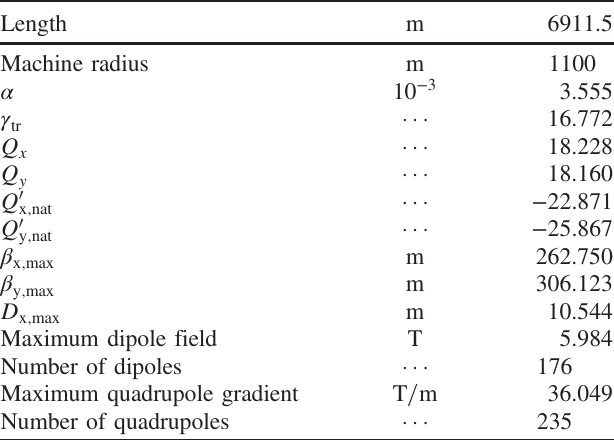
TABLE IX. Parameters of the decay ring.